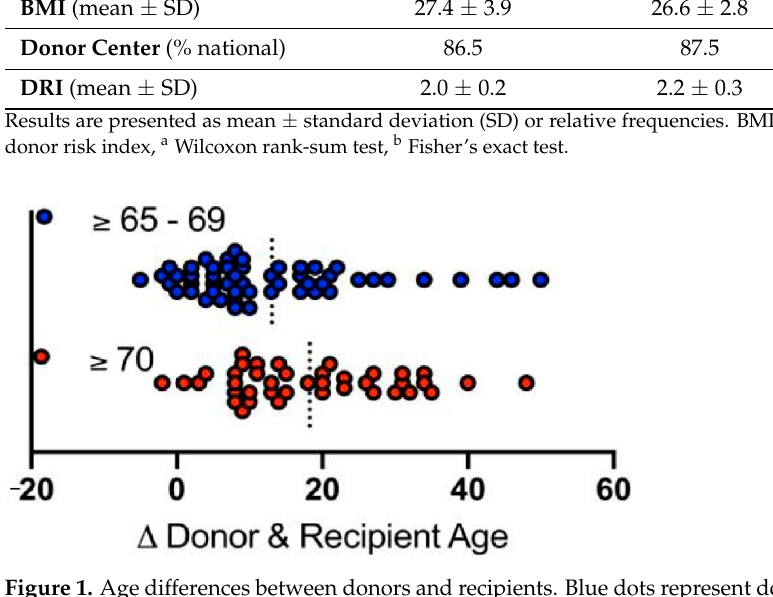
Figure 1. Age differences between donors and recipients. Blue dots represent donors of ≥ 65–69 years, red dots represent donors ≥ 70 years. Dashed bars indicate medians.